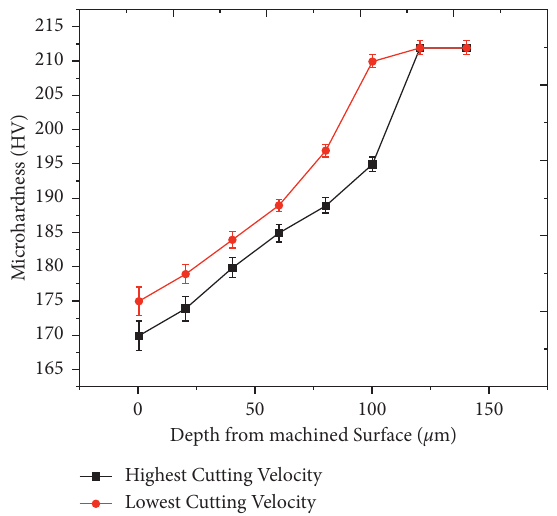
Figure 5: Variation of microhardness at different cutting